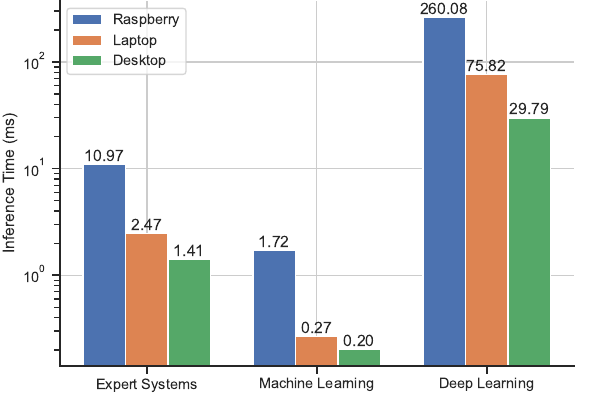
Figure 9. Timing performance comparison across the different platforms. Average SFTP for best solutions of ES, ML, and DL methods. Time values are expressed in milliseconds